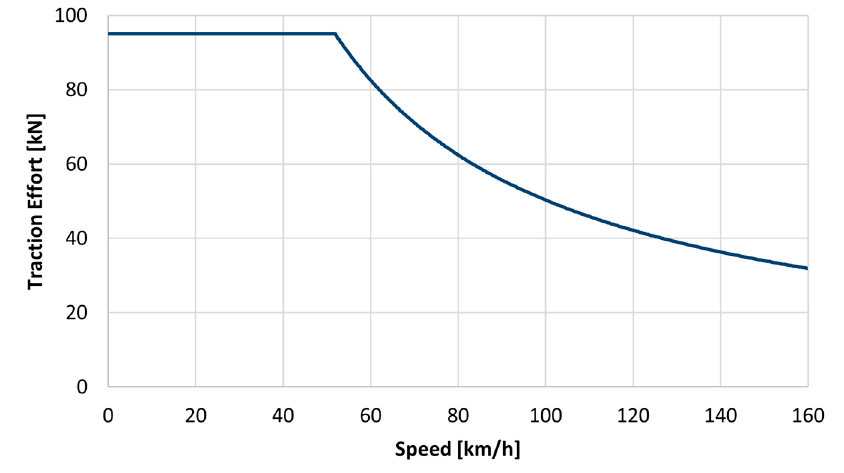
Figure 10. Rolling stock traction curve.